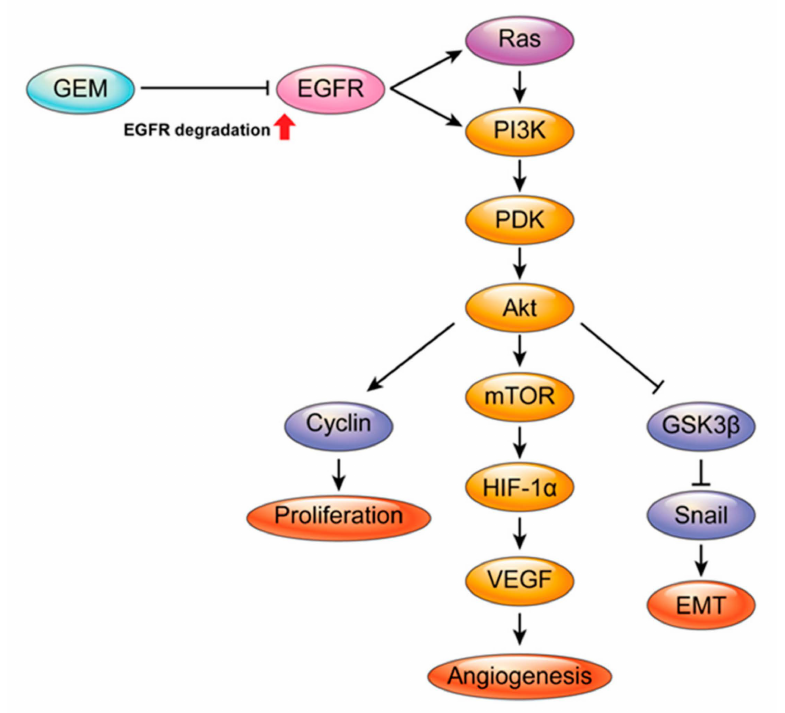
Figure 6. Molecular mechanisms of a gemcitabine-eluting membrane (GEM). Local delivery of gemcitabine via implantation of a GEM induces degradation of epidermal growth factor receptor (EGFR), suppression of EGFR downstream signaling pathways (e.g., cell proliferation, angiogenesis, and the EMT), and reduction of tumor